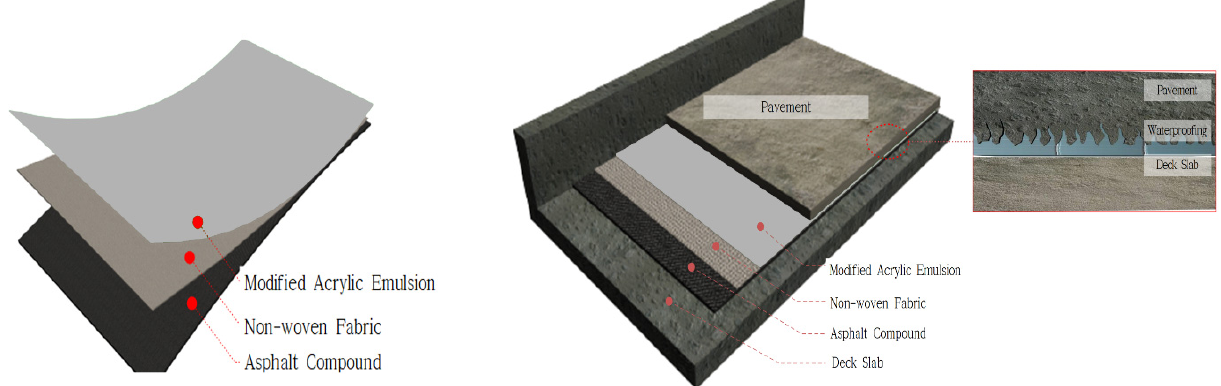
Figure 3. APC and LMC pavement structure with a double-side bonding waterproofing sheet.